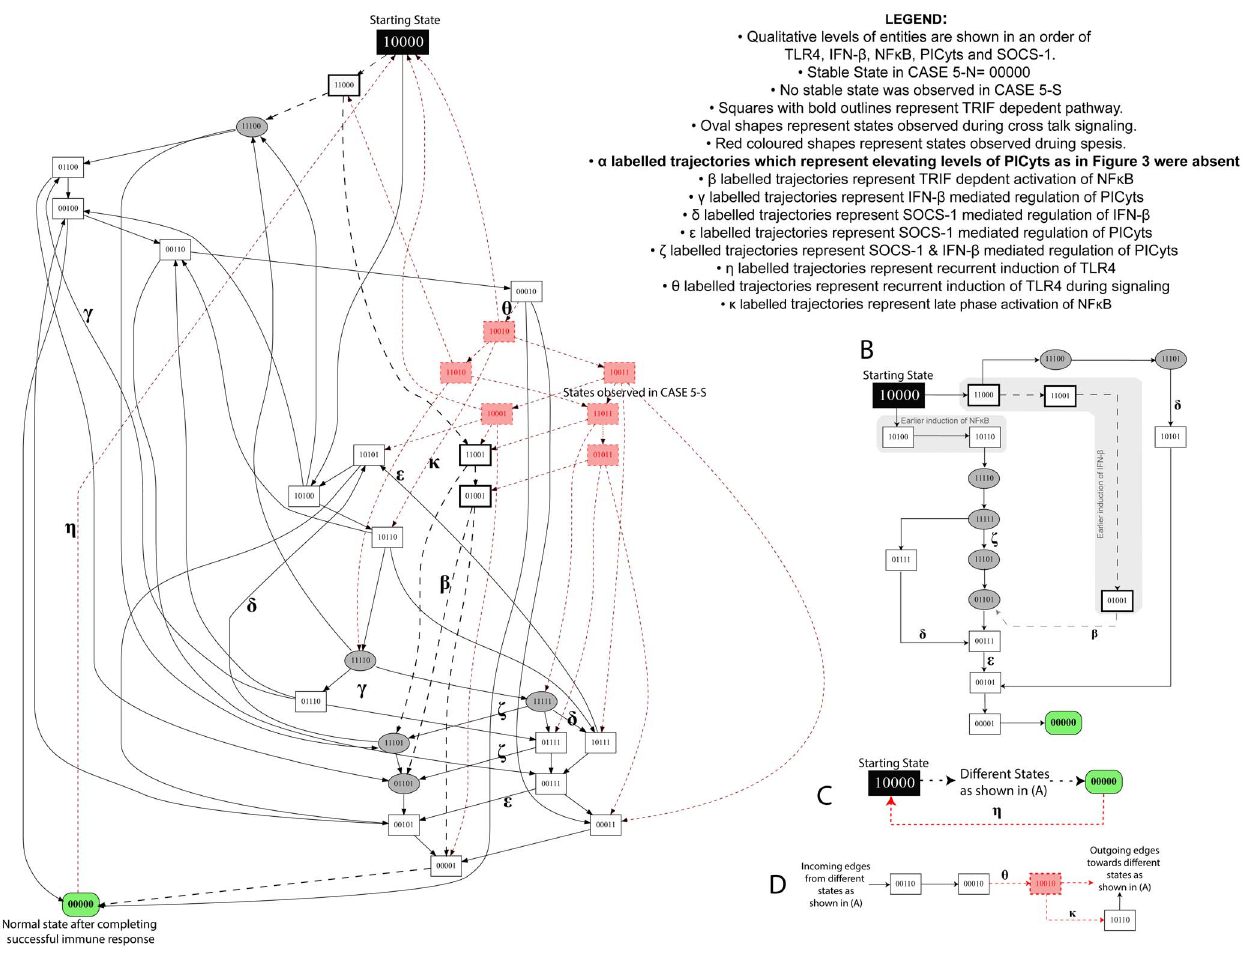
Figure 8. State graph of CASE 5-N and 5-S. (A) Each node represents a particular state observed during signalling associated with CASE 5-N and CASE 5-S. Integers ‘‘0’’ and ‘‘1’’ within the nodes represent qualitative levels of proteins in the order of TLR4, IFN- b , NF k B, PICyts and SOCS-1. Inactive entities are represented by integer ‘‘0’’ whereas active entities are represented by integer ‘‘1’’. Nodes and trajectories, which were specifically observed during signalling dynamics associated with CASE 5-S, are shown in red, whereas common nodes and trajectories found in both CASES are shown in black. Trajectories start from state ‘‘10000’’, representing the activation of TLR4, ultimately, lead towards ‘‘00000’’, which is a stable state in CASE 5-N. On the other hand, a trajectory labelled with ‘‘ g ’’ from state ‘‘00000’’ to starting state ‘‘10000’’ results in a cyclic path during signalling dynamics associated with CASE 5-S. MyD88 and TRIF dependent signalling are shown as black lines and dashed arrows, respectively. Nodes, which represent crosstalk of both signalling pathways i.e. IFN- b and NF k B with qualitative level ‘‘1’’ are presented in oval shapes. Arrows labelled with Greek small letters are used to represent trajectories associated with different signalling events (see legend in the figure). The conditions necessary to produce a state graph shown in the figure are given in Table 3. (B–D) specific states and trajectories which can possibly represent the complete state graph given in (A).